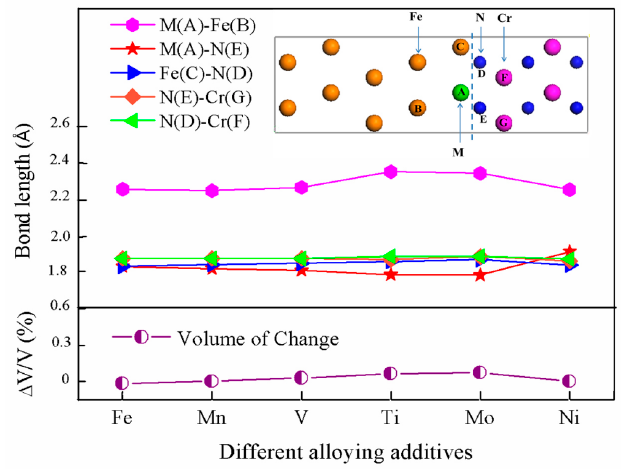
Figure 4. The bond lengths and volume of change of γ‐ Fe/Cr 2 N:M (M = Mn, V, Ti, Mo, and Ni).